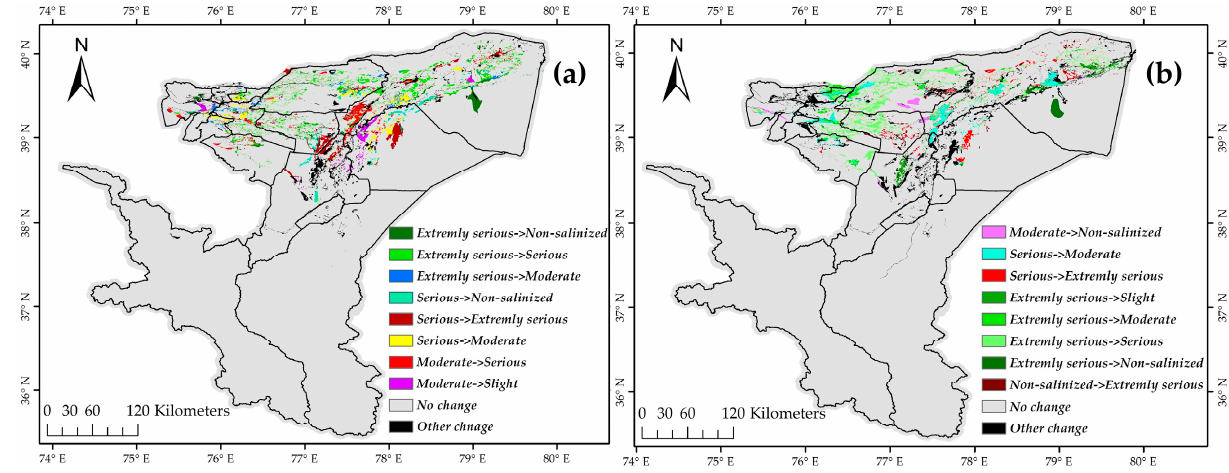
Figure 8. Spatial distribution of dominant change types of salinized soil in 2000–2010 ( a ) and 2010–2017 ( b ).